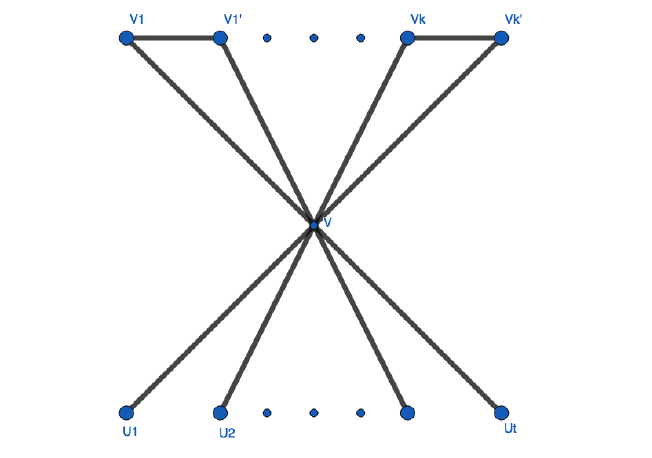
Figure 1. A tight